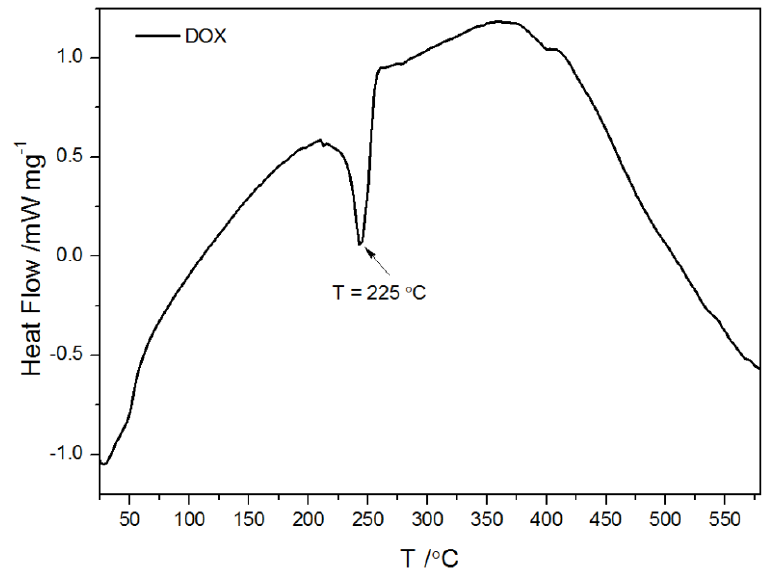
Figure 4. Di ff erential scanning calorimetry curve of pure Figure 4. Differential scanning calorimetry curve of pure DOX.